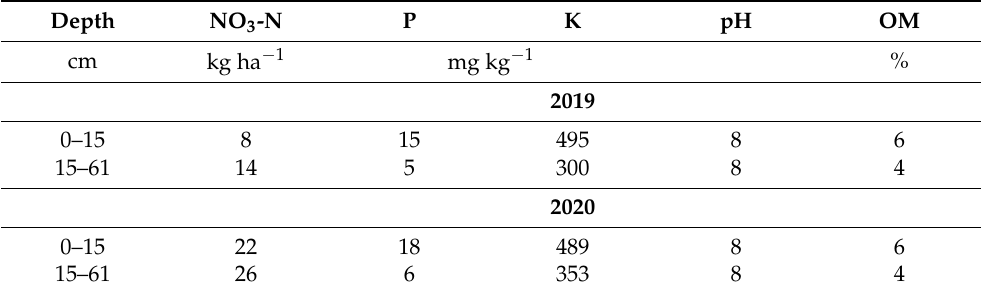
Table 3. Soil test results for soybean environments in 2019 and 2020.